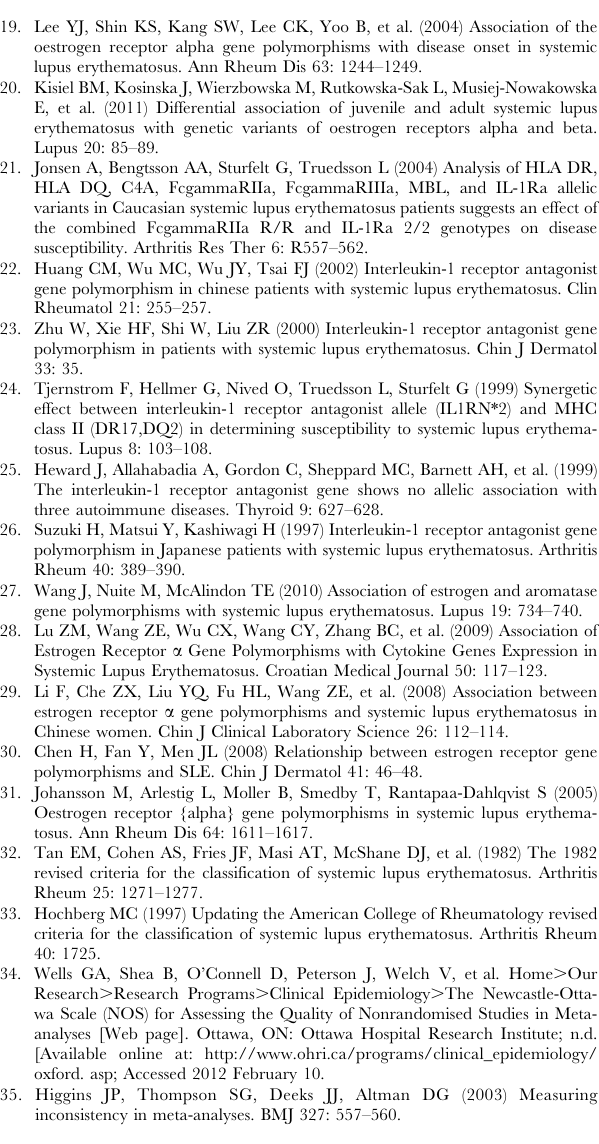
Table S3 Meta analysis of the association of ESR1 Xba I polymorphism with SLE susceptibility. Table S4 The statistical power of IL1-RN VNTR 2 allele in studied included in the meta-analysis. Table S5 The statistical power of ESR1 Pvu II CC/CT genotypes in studied included in the meta-analysis. Table S6 The statistical power of ESR1 Xba I GG/GA genotypes in studied included in the